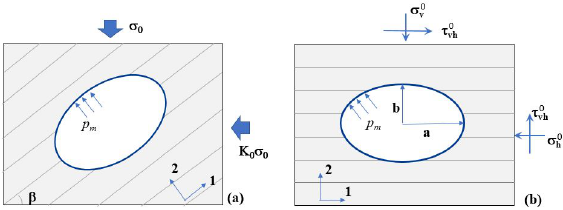
Fig. 1. Elliptical borehole within an infinite transversely isotropic rock under far-field stress and a mud